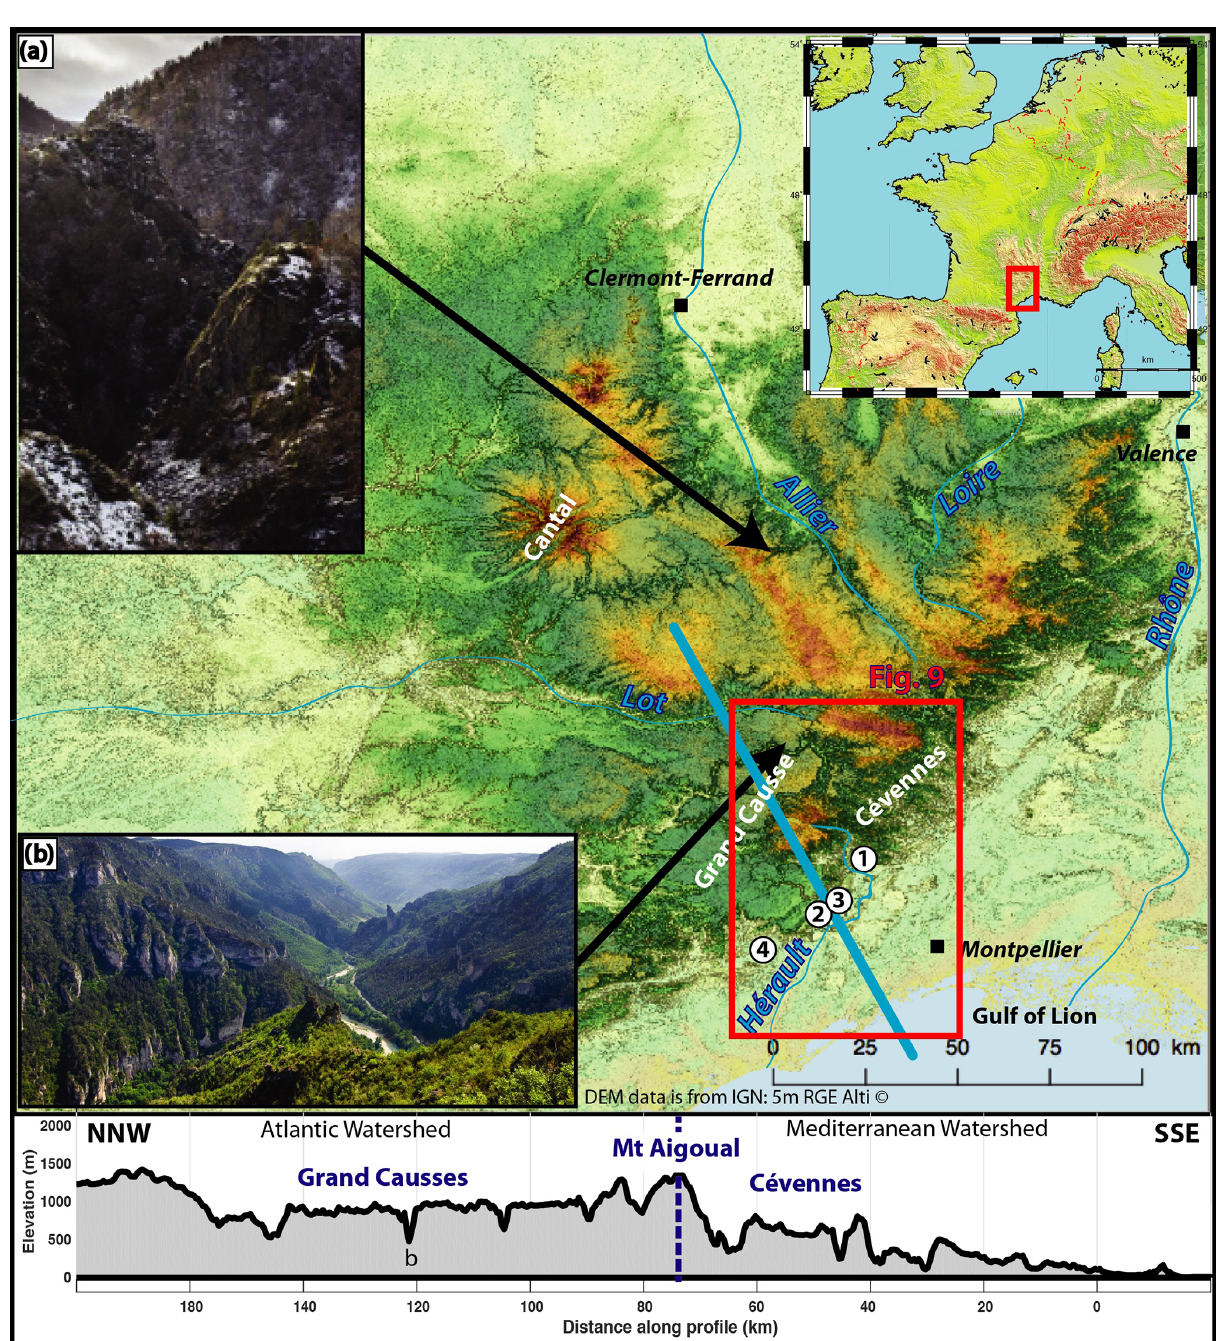
Figure 1. A 30m resolution DEM of the French Massif Central and grey scale underlying the DEM is the DEM derived slope map. Examples of finite incision typical of the French Massif Central in (a) crystalline basement (Seuge canyon) and (b) limestone plateau (Tarn canyon). Location of the study area in red box (Fig. 9) and enumerated site (1) is the Rieutord canyon (43.958 ◦ N, 3.709 ◦ E) where TCN measurements were taken; (2) and (3) are the Leicasse cave system (43.819 ◦ N, 3.56 ◦ E), and the Garrel cave system (43.835 ◦ N, 3.616 ◦ E), respectively, where paleomagnetic analyses have been done, and (4) is the Lodève basin (43.669 ◦ N, 3.382 ◦ E) with dated basaltic flows. Bottom panel is an example of typical topographic profile used for the numerical model set up. Note the southwestern area with large plateau dissected by a canyon, and the rugged area with a steep valley is called the Cévennes. They are typical regional limestone and crystalline morphology,